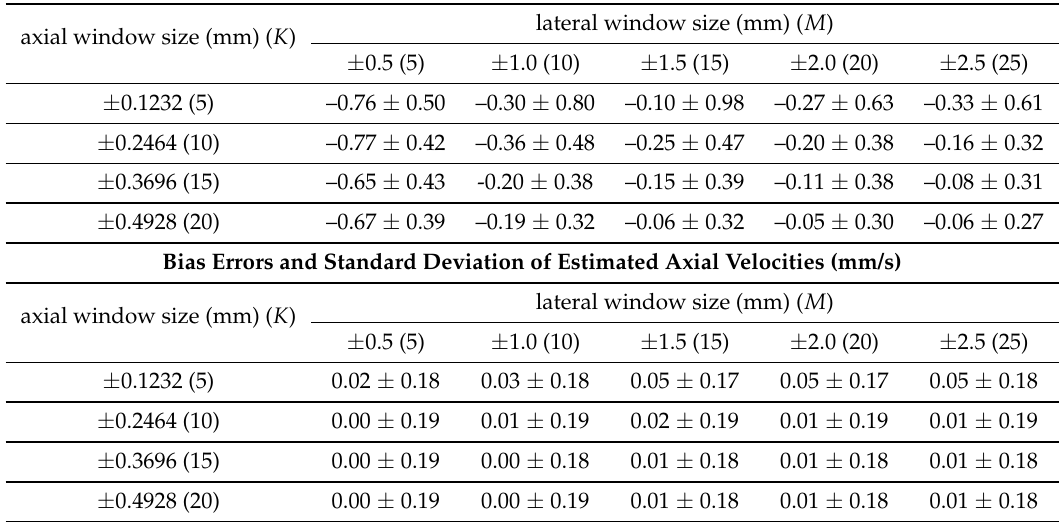
Table 7. Bias errors e bias and standard deviations σ of lateral and axial displacements at nine red points in Figure 4b estimated by the conventional 2D motion estimator with frame averaging.